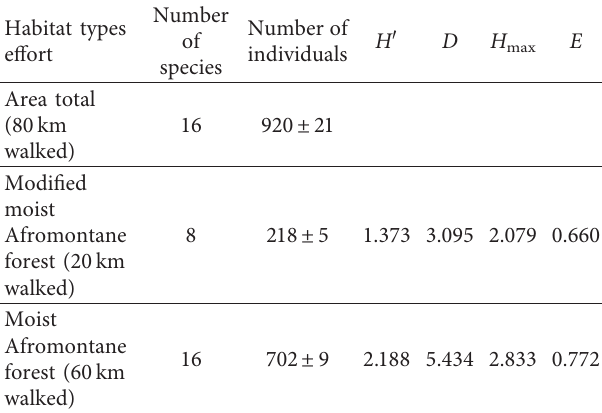
Table 4: Diversity indices of large wild mammals indifferent habitat types of Nensebo forest, Southern Ethiopia.